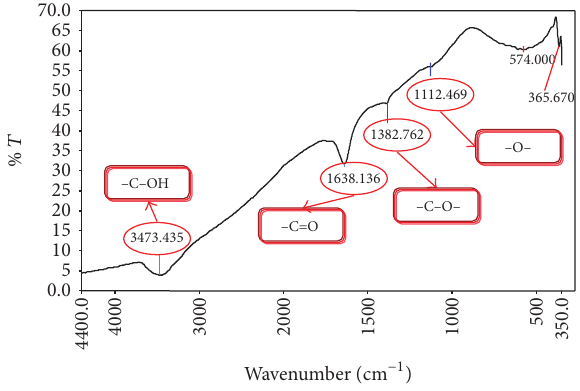
Figure 1: FTIR spectra of GO